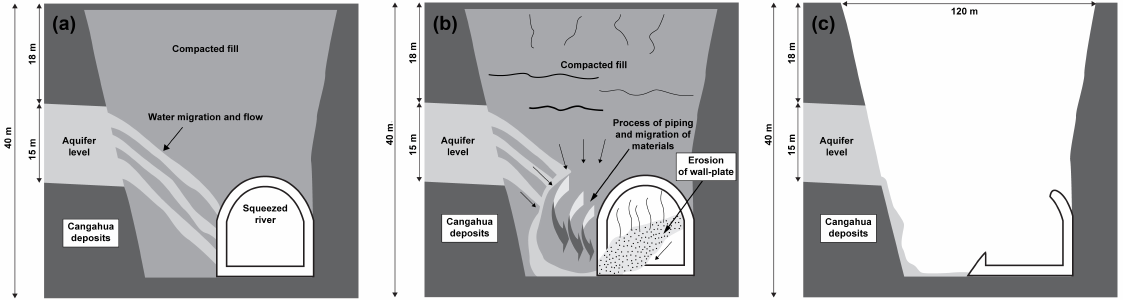
Figure 10. (a) Schematic view of the channelized river, the characteristics of the terrain and of the compacted fill; (b) alteration of the com- pacted fill, process of piping and migration of materials, initial stage of the collapse; (c) formation of sinkhole, material drags surroundings due to river activity.